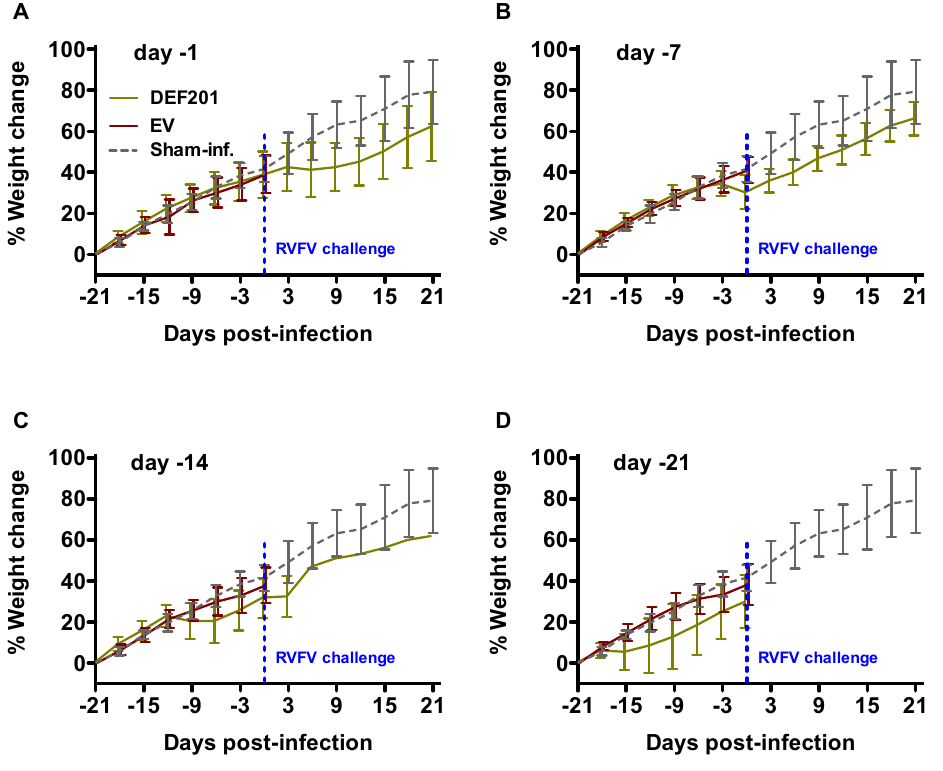
Figure 2. DEF201 treatment results in temporary weight loss. The percent weight change during the course of the DEF201 RVFV pre-exposure prophylaxis experiment presented in Figure 1 is shown. The data for the ( A ) day −1, ( B ) day −7, ( C ) day −14, or ( D ) day −21 treatments are represented as the group mean and standard deviation of the percent change in weight of surviving animals relative to their starting weights on day −21 and measured every 3rd day. Sham-infected normal controls are included for